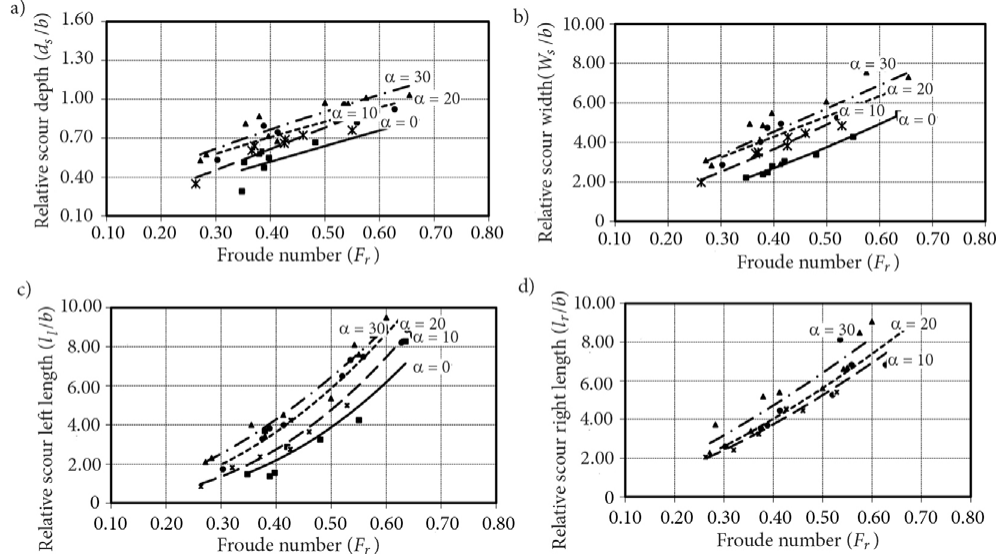
Figure 10. Froude number against relative scour depth, width, left side length and right side length with the varying skew